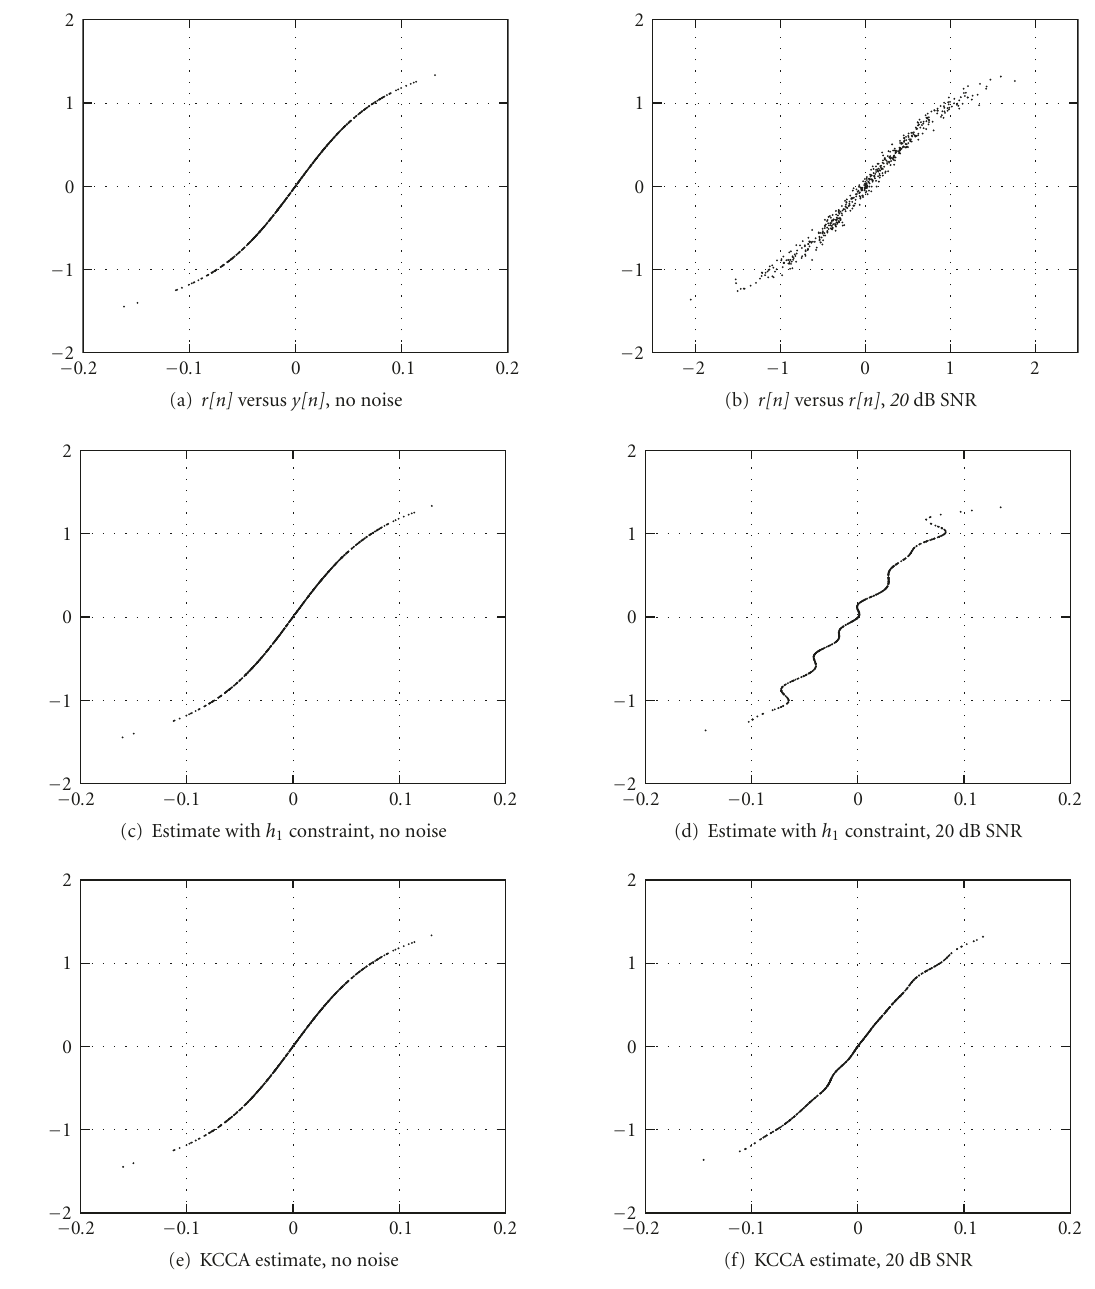
Figure 6: Estimates of the nonlinearity in the static Wiener system. The top row shows the true signal r [ n ] versus the points y [ n ] representing the system nonlinearity, for a noiseless case in (a) and a system that has 20 dB white Gaussian noise at its output in (b). The second and third row show r y [ n ] versus y [ n ] obtained by applying the filter coe ffi cient constraint h 1 = 1 and the signal power constraint (KCCA solution),